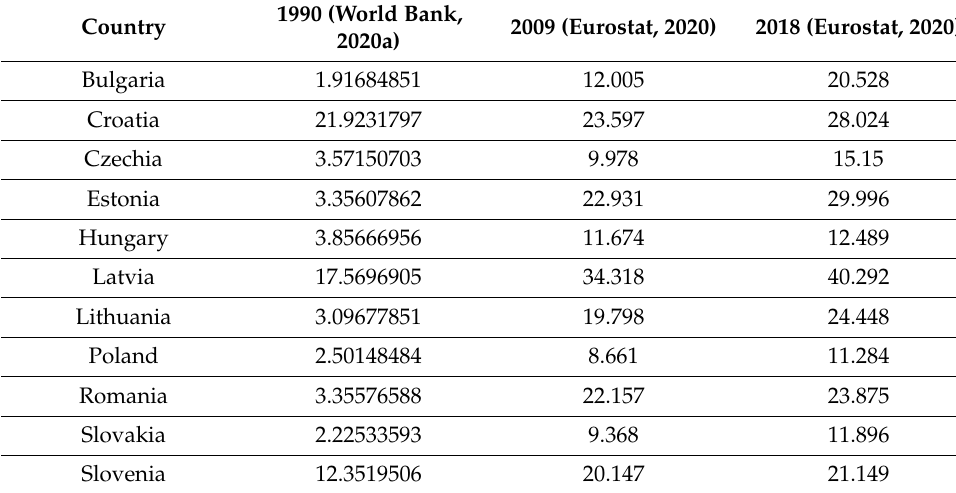
Table 1. Share of energy from renewable sources in total energy (%). 1990 (World Country